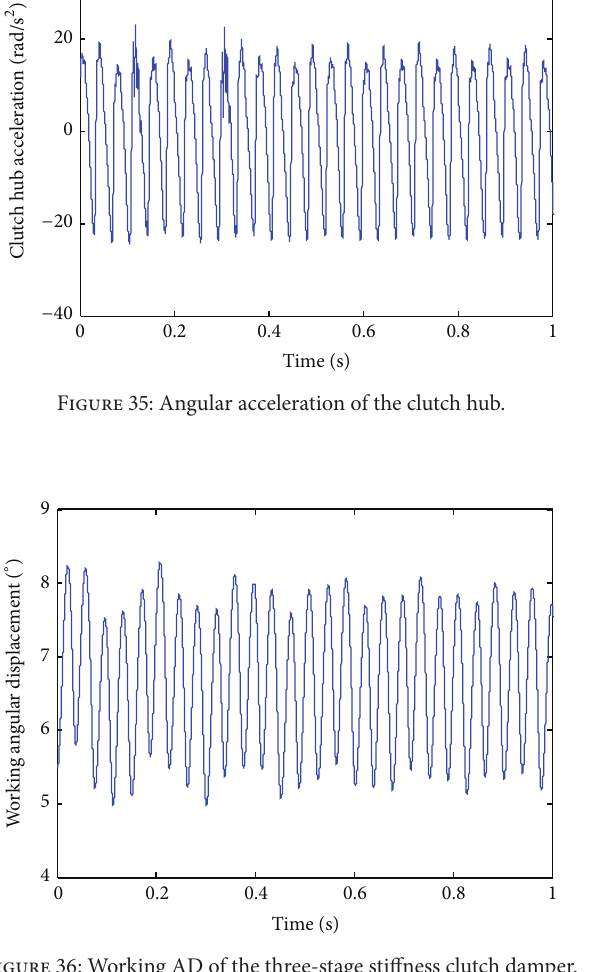
Figure 36: Working AD of the three-stage stiffness clutch damper.